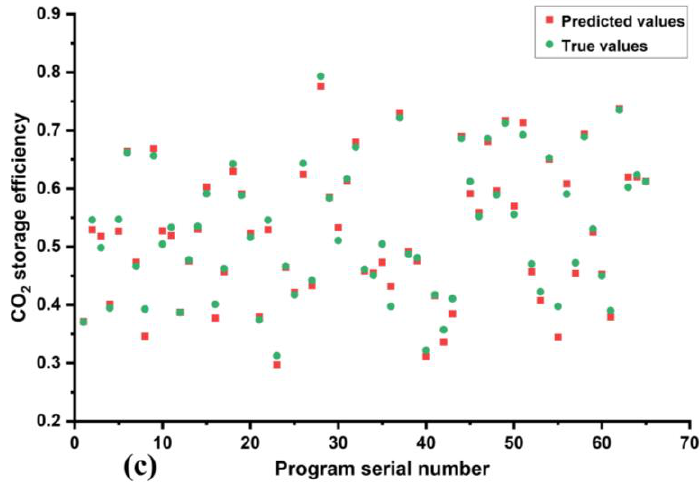
Figure 12. Comparison of the predicted values by random forest algorithm with the true values in ( a ) cumulative oil production, ( b ) CO 2 storage amount, and ( c ) CO 2 storage efficiency. The relative deviation of cumulative oil production, CO 2 storage amount, and CO 2 storage efficiency for each scheme are calculated and shown in Figure 13 for further discussion. The relative deviation of cumulative oil production between prediction and true values ranges from − 4.76% to 2.51%, the maximum relative deviation is − 4.76%, and the average absolute relative deviation is 1.10%. The maximum relative deviation of CO 2 storage amount between prediction and true values is − 15.15%. Except for this, the relative deviation for all other scenarios ranges from − 10.67% to 5.23%. The average absolute relative deviation for predicting CO 2 storage amount is 3.04%. For the prediction of CO 2 storage efficiency, except for three scenarios with large relative deviations of − 13.35%, − 11.93%, and 8.72%, respectively, the relative deviation for all other scenarios ranges from − 6.31% to 4.55%. The average absolute relative deviation for predicting CO 2 storage efficiency is 2.24%.